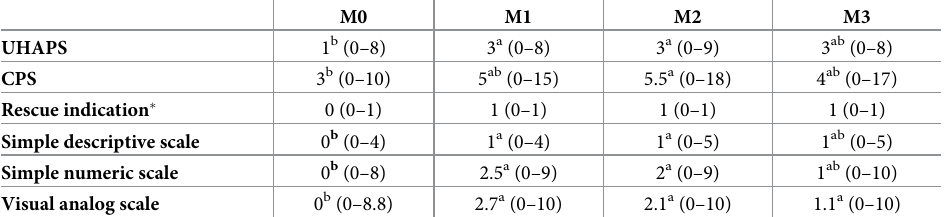
Table 9. Median (range) scores of the Unesp-Botucatu horse acute pain scale (UHAPS), the Composite Pain Scale (CPS), and unidimensional scales in the perioperative period in